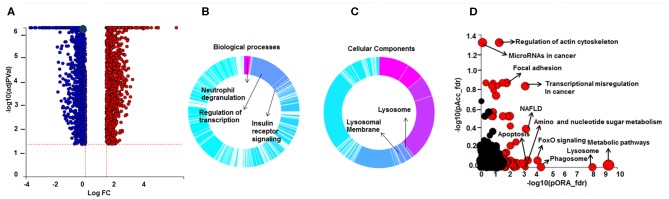
Differential gene expression and Gene Ontology (GO) processes and significant pathways between DEX-treated compared to untreated sarcoid AMs. (A) Volcano plot: 2,834 significant DE genes analyzed by DEseq2 analysis tool are represented in terms of their measured expression fold change (log2FC) on the x-axis and the significance of the change (–log10 adj p-value) on the y-axis. The dotted lines represent the thresholds used to select the DE genes: log2-fold change (>0.6) and significance (FDR < 5%). The up-regulated genes (positive log2FC) are shown in red, while the down-regulated (negative log2FC) genes are shown in blue. (B,C) Gene Ontology (GO) analysis of DE genes. To assess the enrichment of GO terms Elim pruning method was used. GO analysis identified top (B) biological processes and (C) cellular components. (D) Pathway analysis on the DE genes was performed considering a threshold of log2 FC > 0.6 and FDR < 5% using iPathwayGuide analysis tool that uses two types of evidence: the over-representation on the horizontal axis (pORA) and the perturbation on the vertical axis (pAcc). Significant pathways (FDR < 5%) are shown in red, whereas non-significant are in black. The size of the circle is proportional to the number of genes in that pathway.